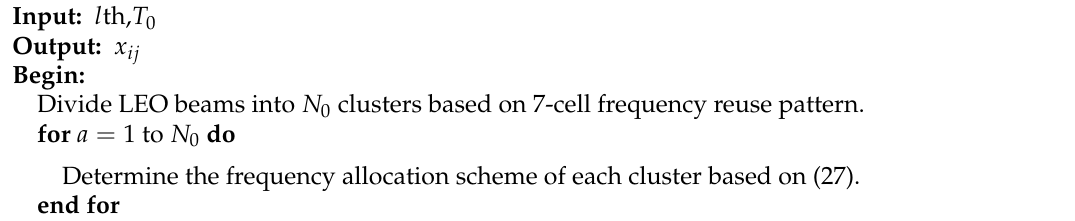
Algorithm 1 Dynamic requency allocation algorithm.